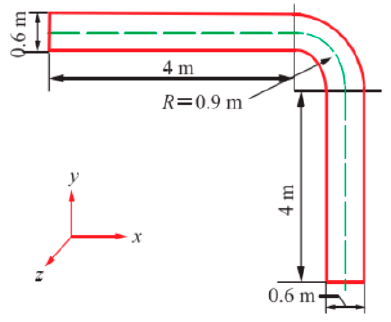
Figure 3. The model diagram of the elbow in references.